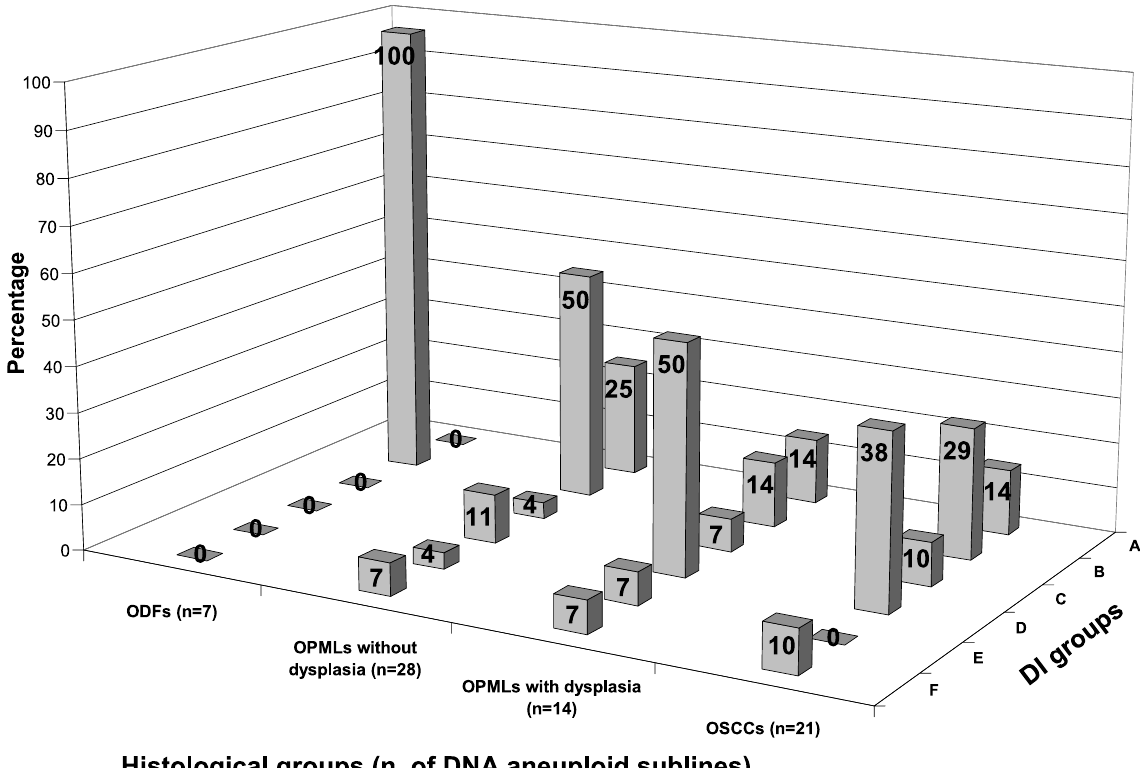
Fig. 3. DNA aneuploid sublines ( n = 70) detected by high resolution DNA FCM in the following histological groups: non-dysplastic ODFs, OPMLs without and with dysplasia and OSCCs. The number of the corresponding DI aneuploid values were, respectively, 7, 28, 14 and 21. DI values were subdivided in the following 6 groups: (A) hypo-diploid ( DI < 1); (B) hyper-diploid near-diploid (1 < DI < 1 . 4); (C) near-triploid (1 . 4 (cid:3) DI (cid:3) 1 . 6); (D) hypo-tetraploid (1 . 6 < DI (cid:3) 1 . 97); (E) tetraploid (1 . 97 < DI < 2 . 03); (F) hyper-tetraploid ( DI (cid:2) 2 .